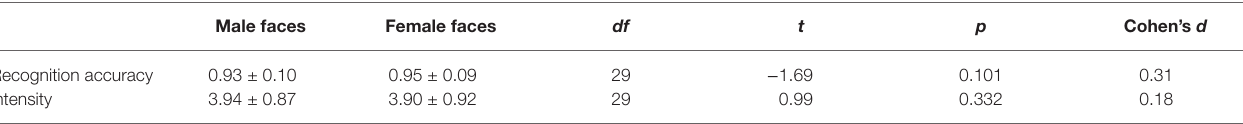
TABLE 2 | Evaluation scores of stimuli from different facial gender (M ±